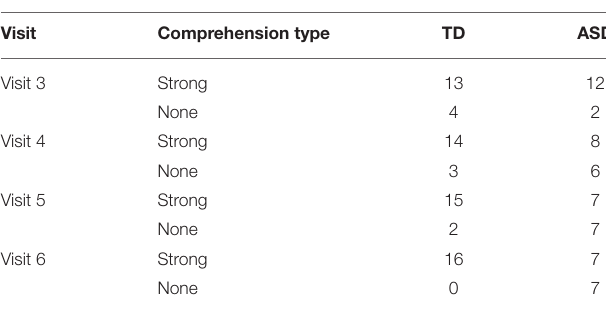
TABLE 4 | Number of children showing comprehension or no comprehension of Wh-questions (subject—and object—questions